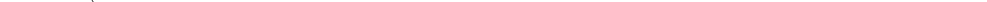
figure on next Fig. 3 Histograms of the subjective scores of artery depiction in ND‑CM, LD‑CM, and VMI scores of the abdominal aorta, its main branches, and pancreatic arteries in ND‑CM (0.8 mL/kg, 400 mgI/mL, and 320 mgI/kg), LD‑CM (0.56 mL/ kg, 400 mgI/mL, and 224 mgI/kg), and VMI (SMA) were graded using a 4‑point scale: 1 pancreatic arteries was graded using a 4‑point scale: 0 3 completely visible. ND-CM normal‑dose contrast medium, LD-CM low‑dose contrast medium, VMI =